Question: Express in one sentence what the figure is showing.
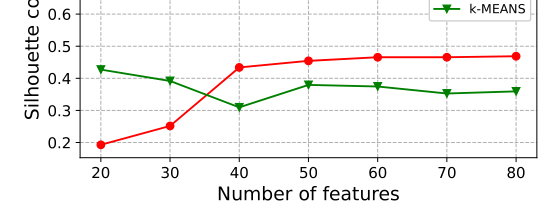
Answer: The relationship between the number of features and the silhouette coefficient.